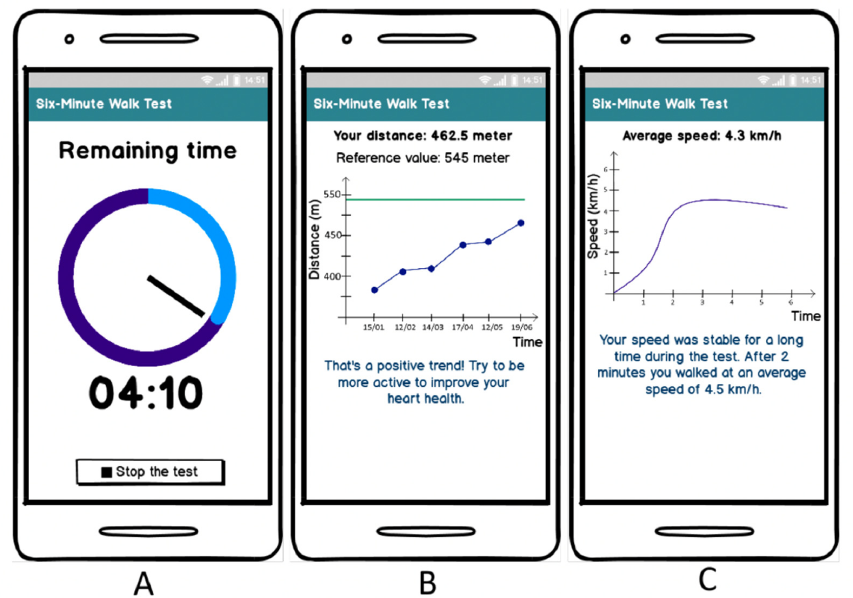
Figure 9. Mockups of a smartphone application to support cardiovascular disease patients in per- forming a self-administered six-minute walk test at home. ( A ) Feedback during the test, ( B ) progress follow-up after the 6MWT, and ( C ) walking speed details after the 6MWT. 6MWT: six-minute walk test.